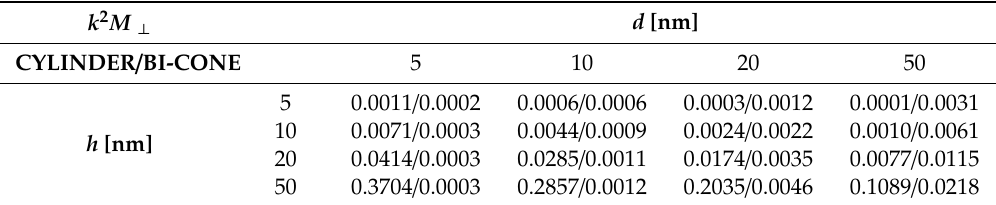
Table 3. Correction factor k 2 M ⊥ dependence on nanoparticle dimensions for cylinder (the first row) and bi-cone at fixed wavelength λ = 632 nm.